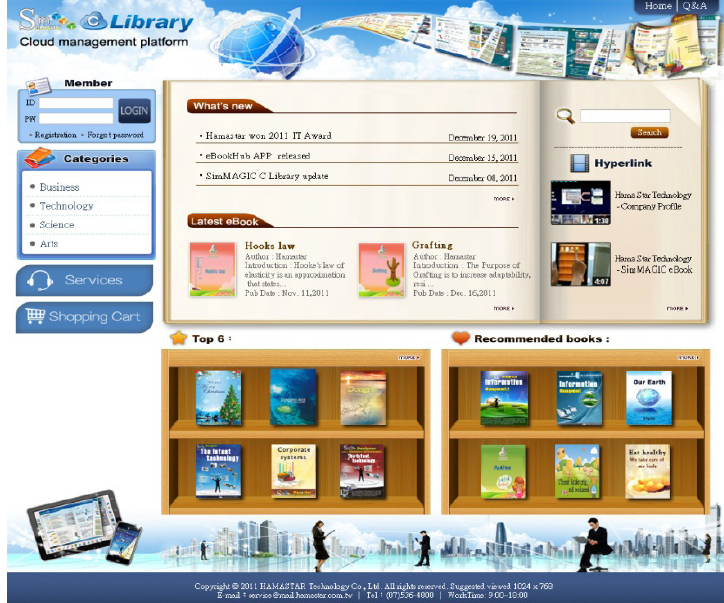
Figure 6 . SimMAGIC C-Library